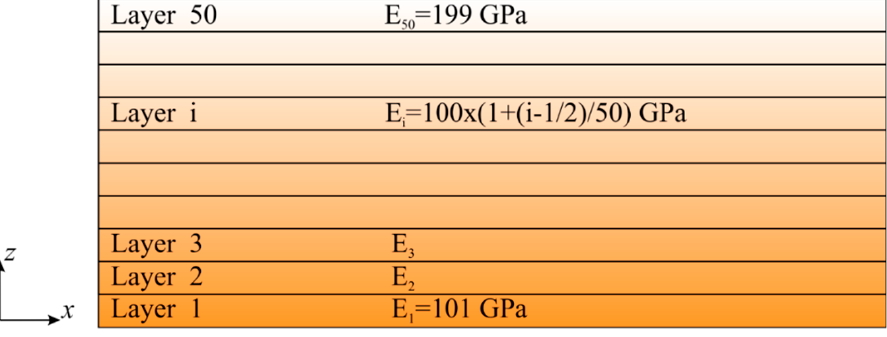
Figure 3. Variation of material properties through the thickness direction for the finite element model.